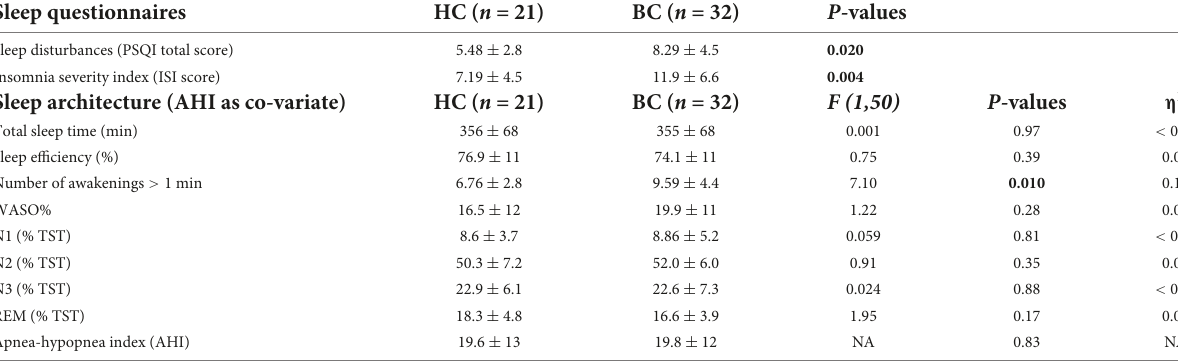
TABLE 2 Sleep characteristics, i.e., subjective sleep quality and sleep architecture (mean ±